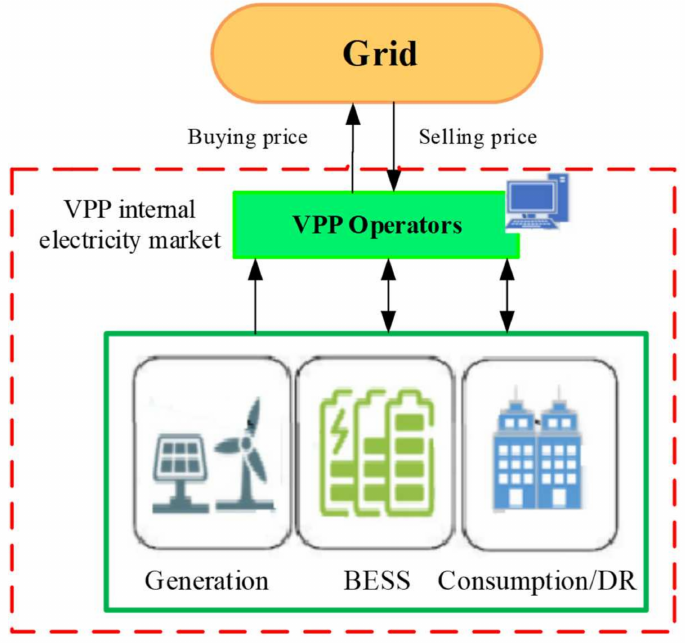
Figure 2. Proposed VPP electricity market